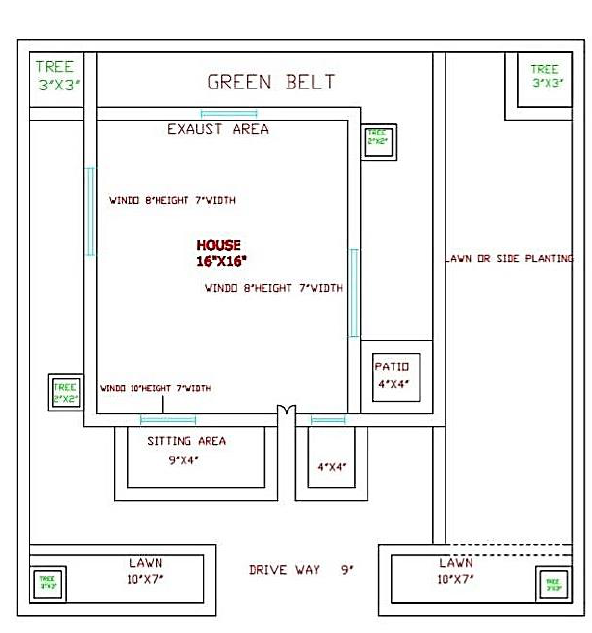
Figure 1: Scheme of the test